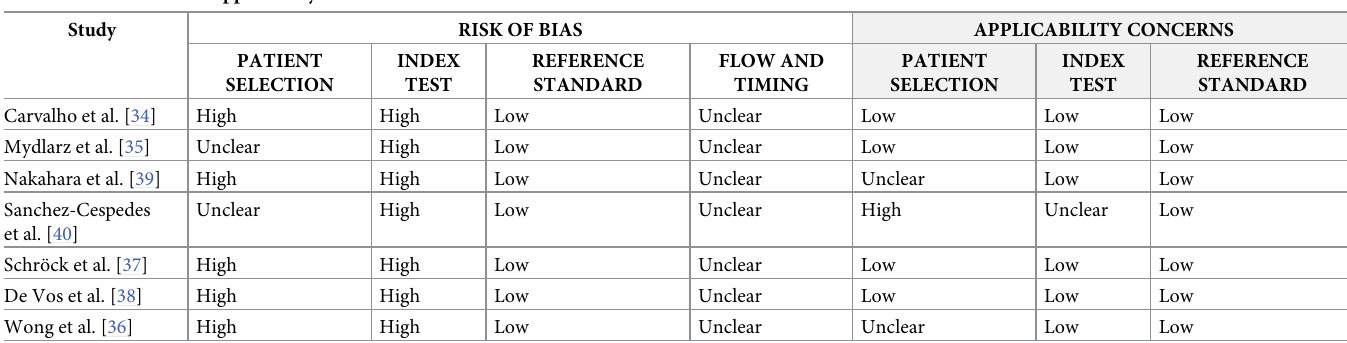
Table 3. Risk of bias and applicability